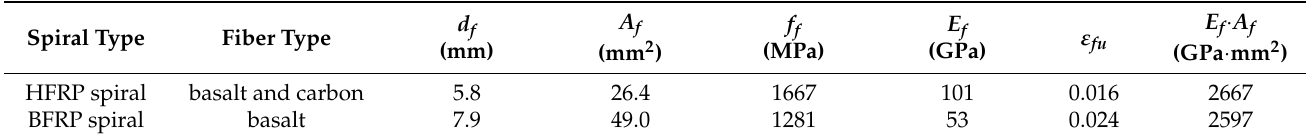
Table 3. Physical and mechanical properties of reinforcements.